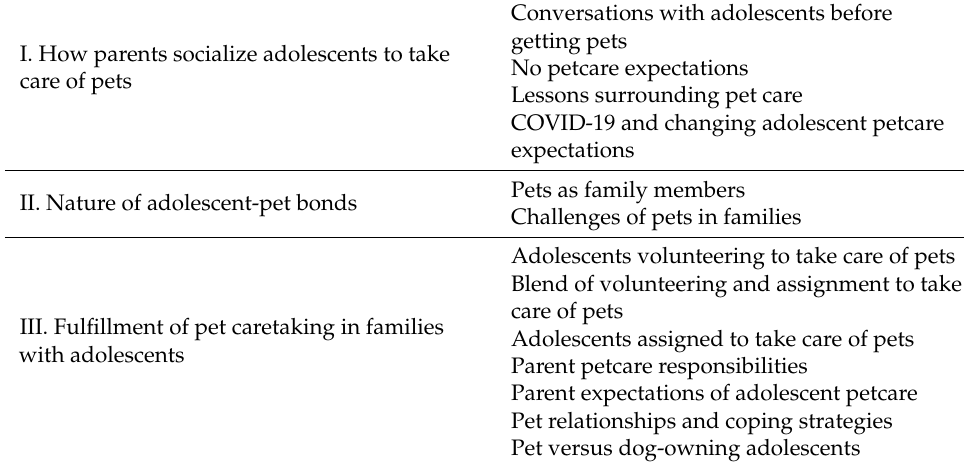
Table 3. Qualitative